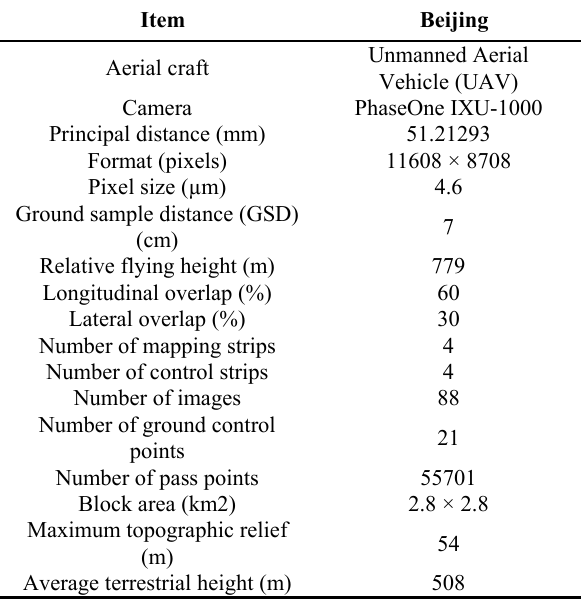
Table 1. Technical parameter of the test images